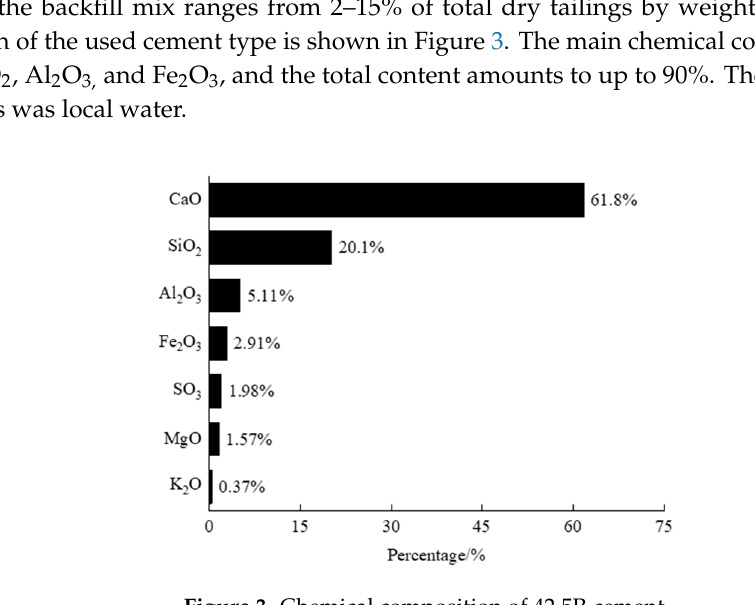
Figure 4. The preparation process of cement tailings backfill (CTB) mixes.